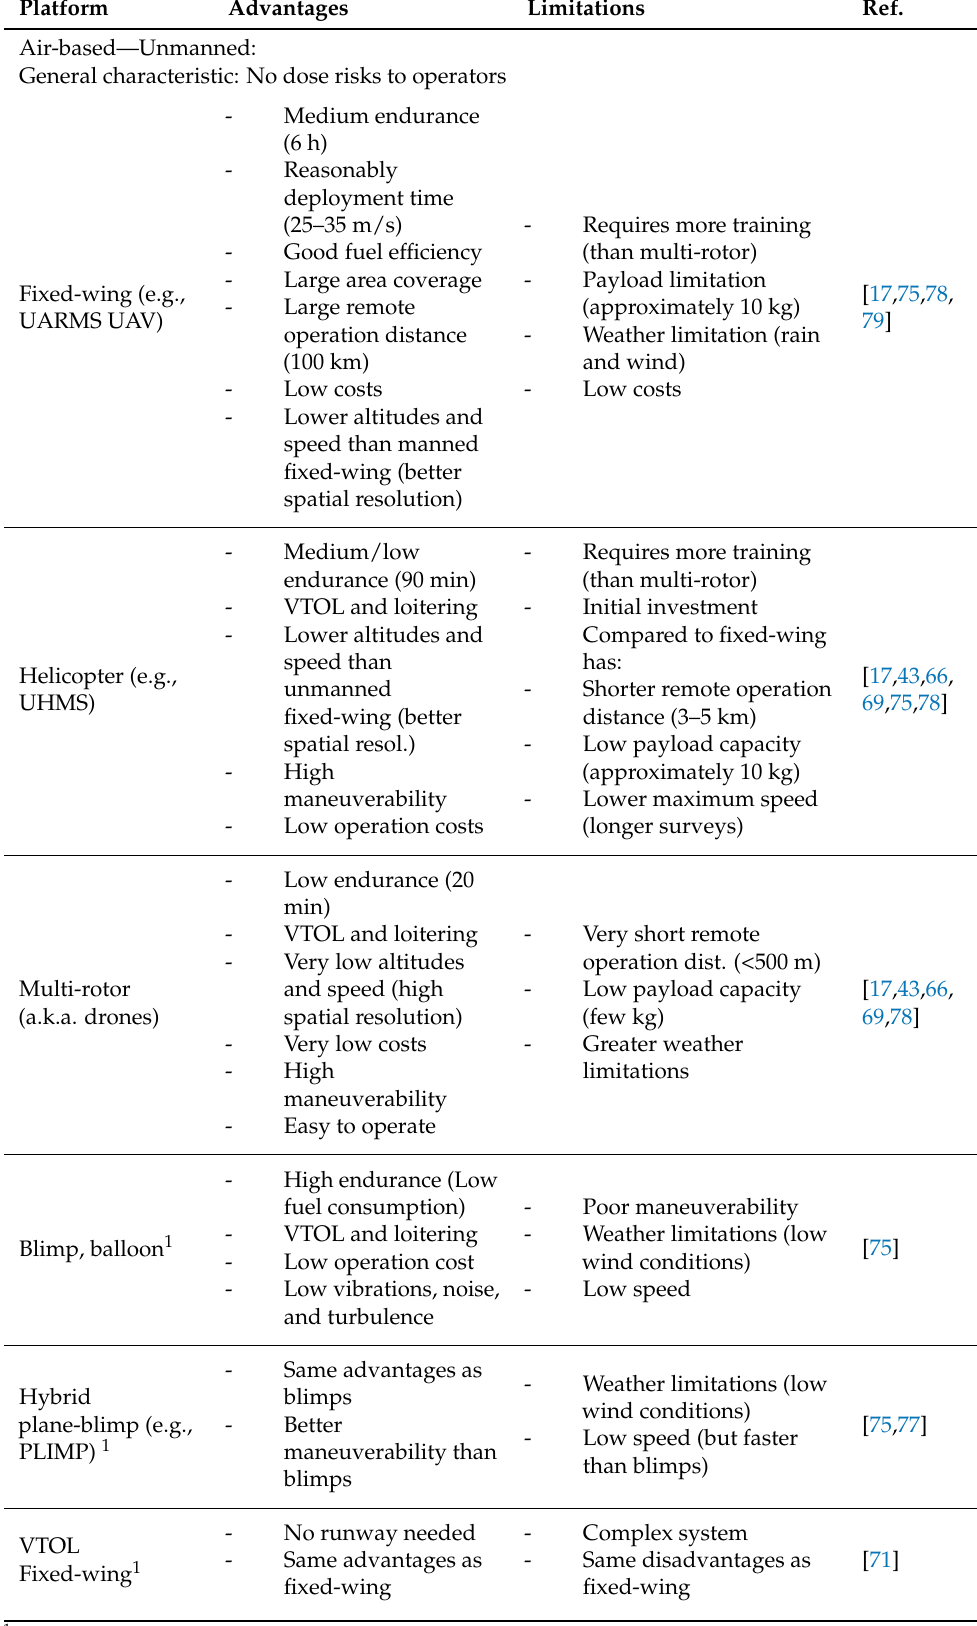
Table 2. Cont. Platform Advantages Limitations